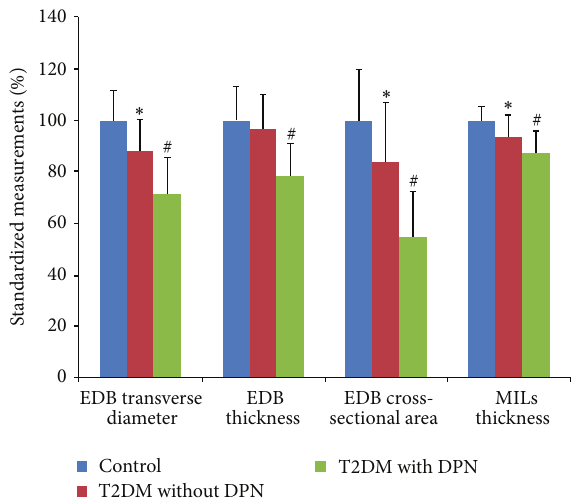
Figure 2: Standardized measurements of the extensor digitorum brevis muscle (EDB) and the muscles of the first interstitium (MILs). The graph shows the standardized measurements when the measured values of the control group are normalized as 100. ∗ indicates 𝑃 < 0.01 when compared with the control group. # stands for 𝑃 < 0.01 when compared with the T2DM without DPN